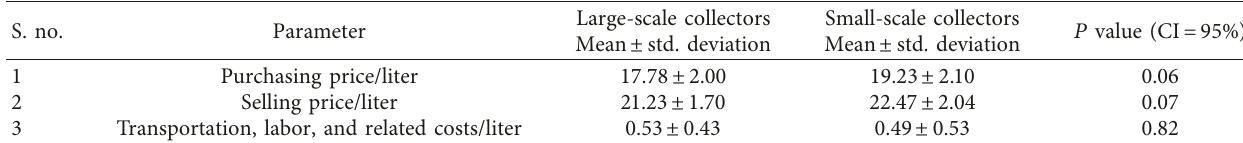
Table 5: Average milk purchasing and selling